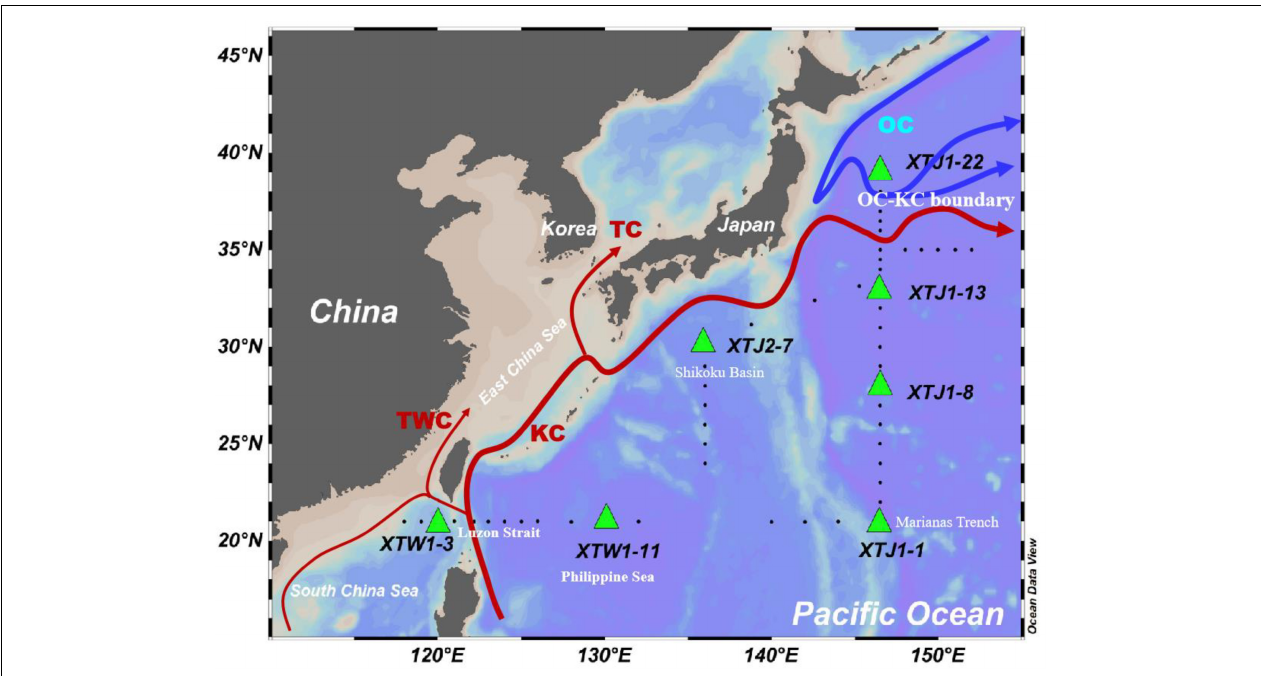
FIGURE 1 | Map of the bathymetry and the locations of the sampling stations (black dots) studied during the cruise in the w-NPO. The green triangles indicate the stations where 210 Po and 210 Pb activities were measured. The arrows represent the surface circulation systems of the w-NPO (Yasuda, 2003; Gallagher et al., 2015; Hu et al., 2015). TWC, Taiwan Warm Current; KC, Kuroshio Current; TC, Tsushima Current; OC, Oyashio